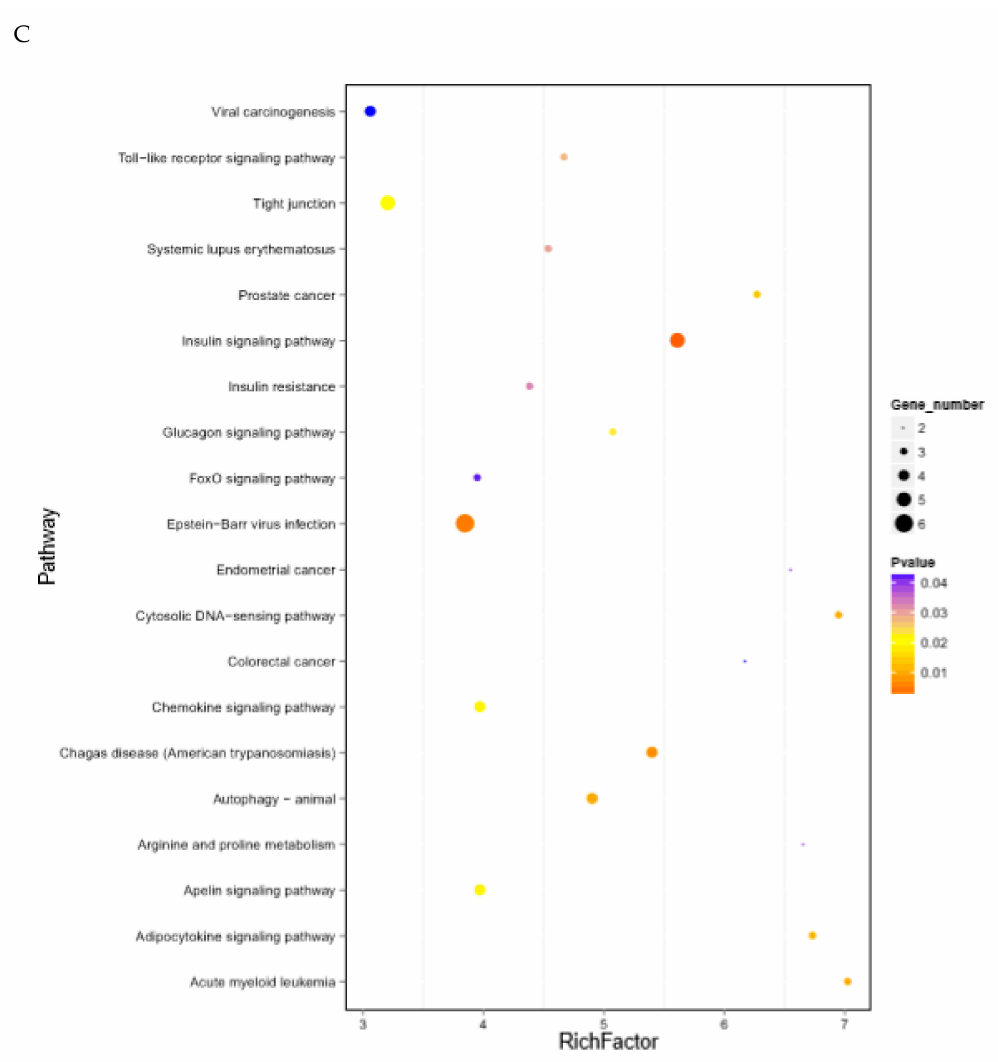
Figure 3. Gene expression analysis in ctrl and CSRP3 silenced cells by RNA sequencing. ( A ) Hierarchical clustering and heatmap of significant di ff erence genes between chicken myoblasts transfected with control and CSRP3 siRNA. ( B ) Gene ontology (GO) enrichment analysis of significant di ff erential expression genes between chicken myoblasts transfected with control and CSRP3 siRNA. ( C ) Pathway enrichment analysis of significant di ff erential expression genes between chicken myoblasts